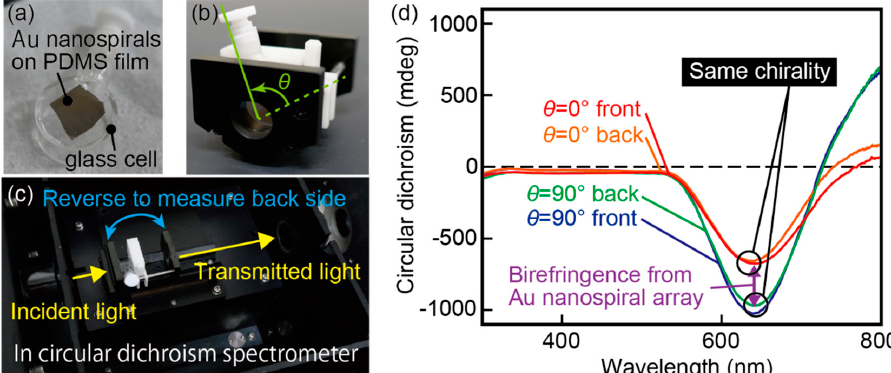
Figure 6. Transmission characteristics when light is incident from the front and back of the device and from the front and back of the device at a 90° tilt. The transmission characteristics of the front and back surfaces at the same angle were almost identical. The circular dichroism measurement error is confirmed by the linearity of the birefringence. ( a ) PDMS thin film with Au nanospiral structures on a glass cell. ( b ) Glass cell holder and tilt angle of the glass cell. ( c ) Setup of the circular dichroism measurement. ( d ) Circular dichroism spectrum of the device which has left-handed Au nanospiral structures for front side and back side illumination with θ = 0° or 90°. The circular dichroism spectra of the right- and left-handed Au nanospiral structures, which were prepared by changing the rotation direction during cryogenic glancing angle deposition (Figure 5a and Figure 7a), are shown in Figure 7b. Figure 7c is an SEM image of a top view of the right- handed Au nanospiral structures. Figure 7d is an SEM image of a top view of the left-handed Au nanospiral structures. The top view images indicated that the structures are moderately curing. Their curling direction are reversed between the Figure 7c,d, which are corresponding to the handedness